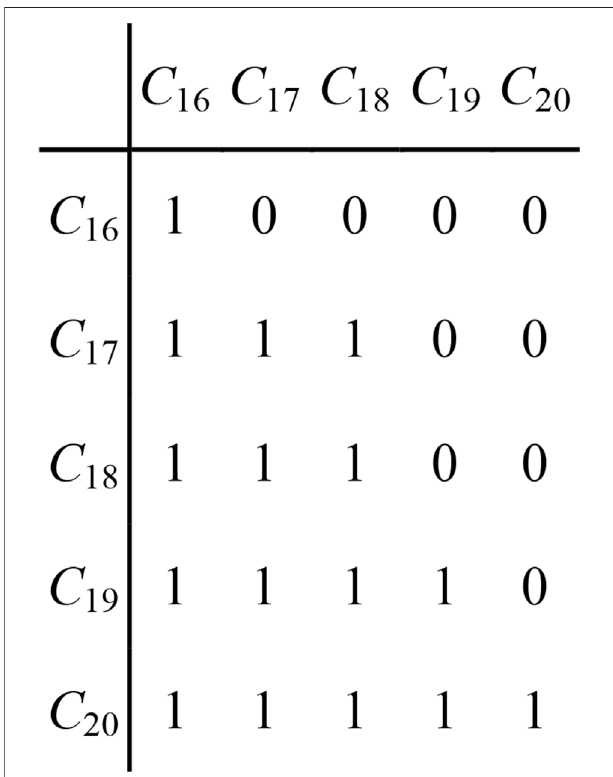
FIGURE 10 | Reachable matrix of M 5 for grab.